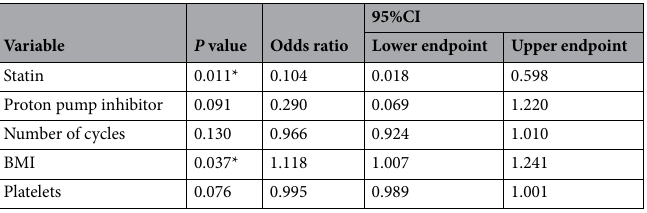
Table 2. Results of multivariate ordered logistic regression analysis for variables extracted by forward selection (n = 78). CI, confidence interval; BMI, body mass index. * P <